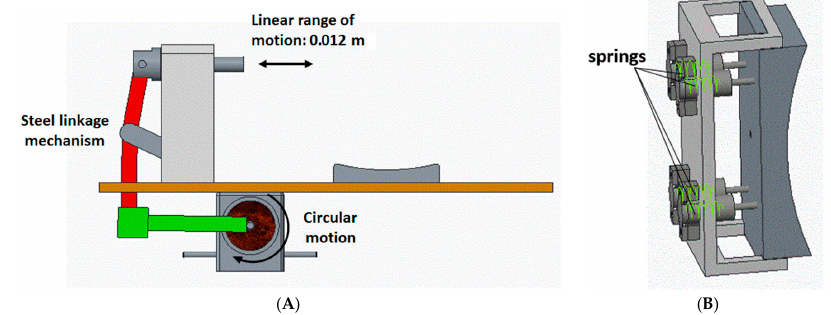
Figure 4. CAD illustrations of ( A ) linkage mechanism of the device; and ( B ) moving pad with spring plungers.